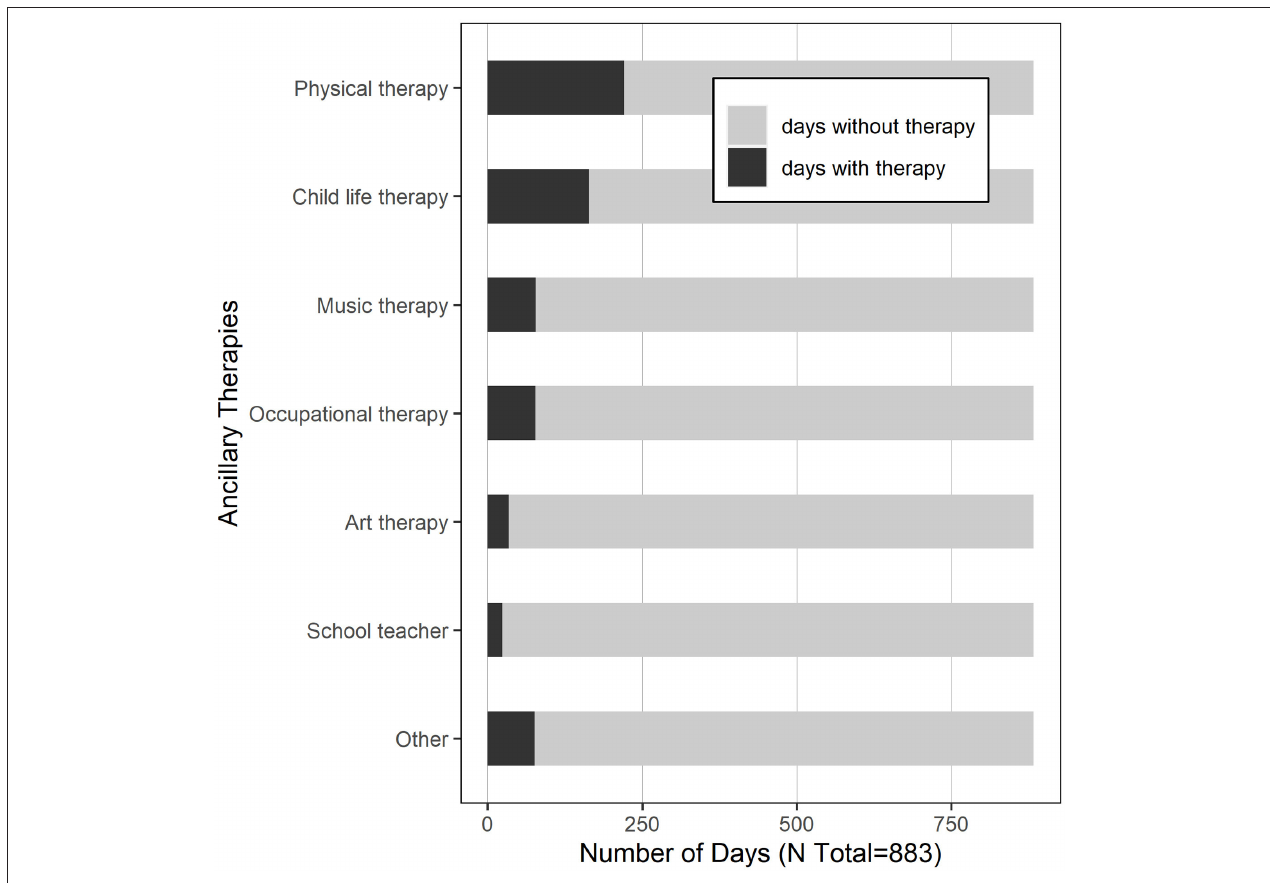
FIGURE 3 | Hospital days with ancillary therapies